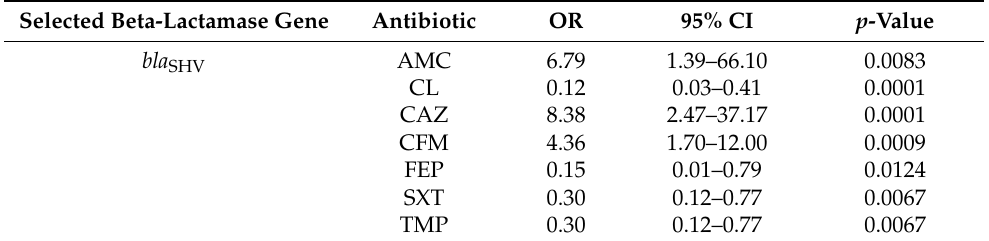
Table 3. Statistically significant associations between β -lactamase gene and antimicrobial resistance in ESBL-producing E. coli